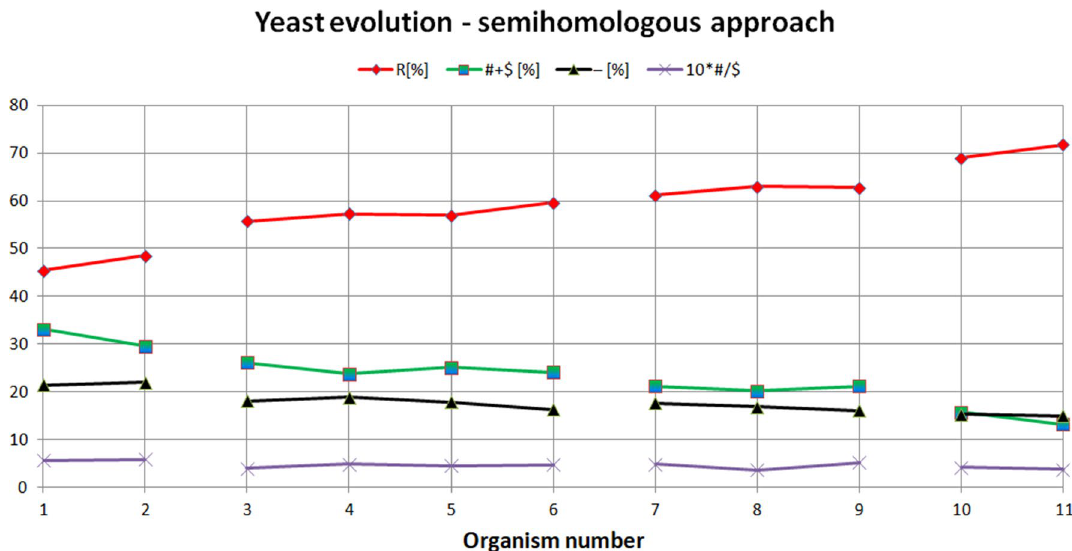
Figure 5. Yeast evolution examined using semihomologous approach. The organisms presented on the X-axis are set in the order determined by the neural network from the organism most evolutionarily distant from Saccharomyces cerevisiae (organism number 1 on the X-axis, i.e. Schizosaccharomyces pombe ), to the organism closest to Saccharomyces cerevisiae (organism number 11 on the X-axis, i.e. Saccharomyces paradoxus ).